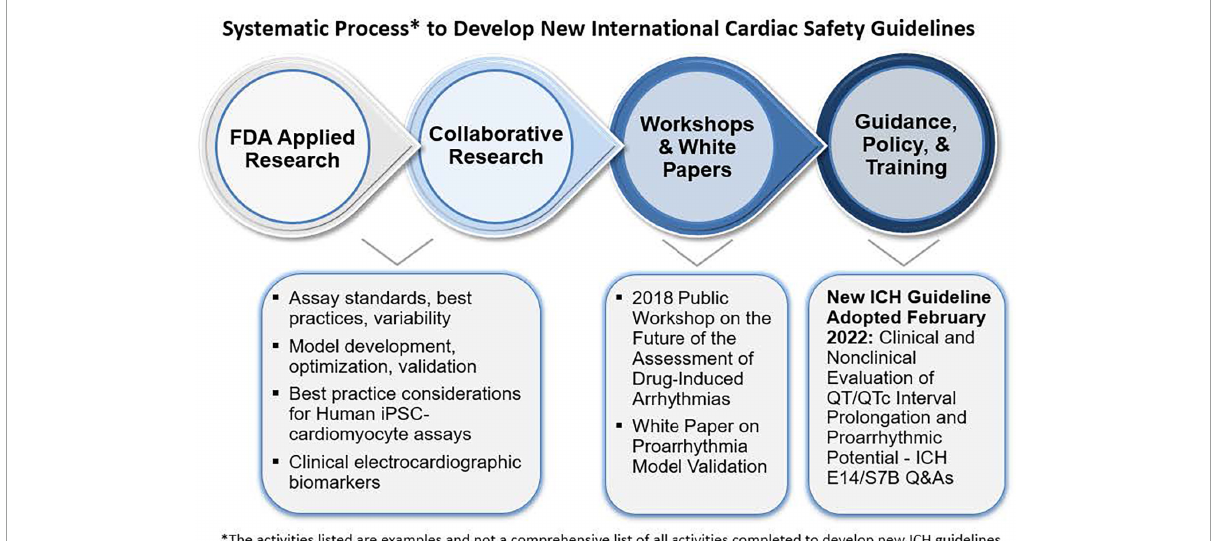
FIGURE11 Under the comprehensive in vitro proarrhythmia assay (CiPA) initiative, division of applied regulatory science (DARS) (along with colleagues from CDER’s office of new drugs) developed a non-clinical model (94) to evaluate the risk of drugs causing abnormal heart rhythms with a high level of predictivity. DARS also leads research in collaboration with external consortia to overhaul the approach to assessing the risk of abnormal heart rhythms for all new drugs and update regulatory